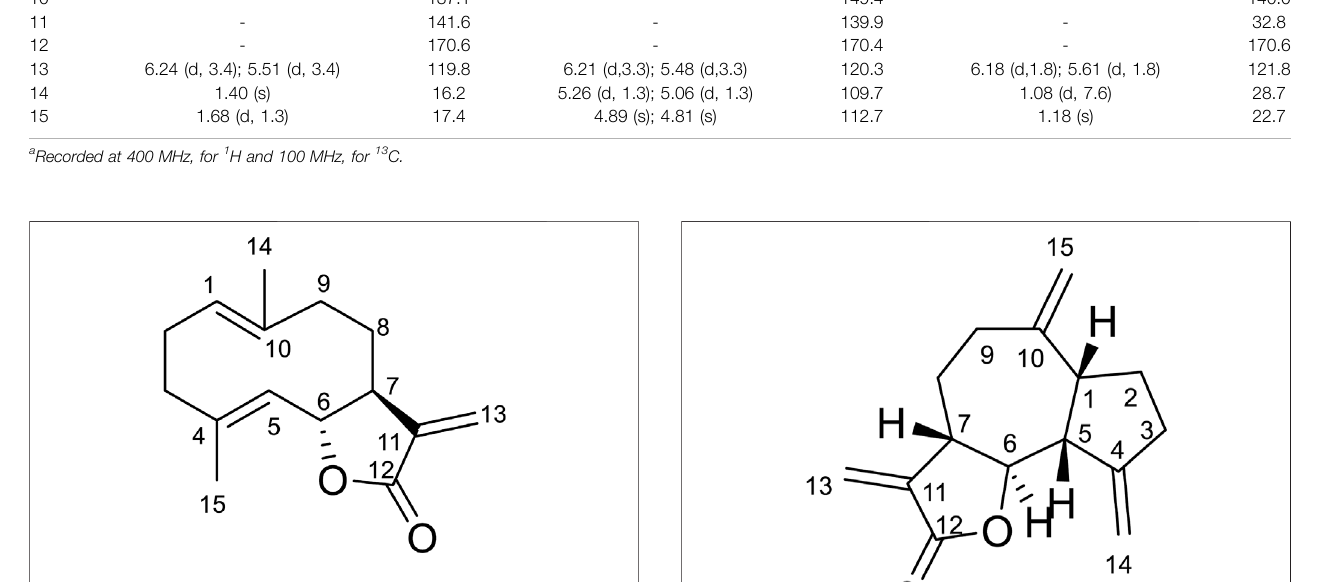
FIGURE 1 | Chemical structural of costunolide.